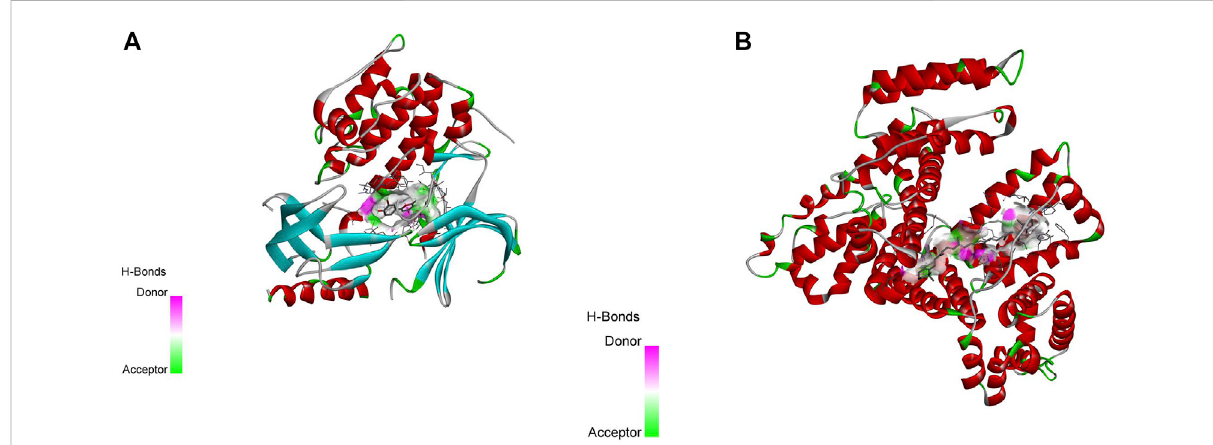
FIGURE 5 Diagram of Molecular docking model. (A) The docking diagram of quercetin and AKT1. (B) The docking diagram of β -carotene and